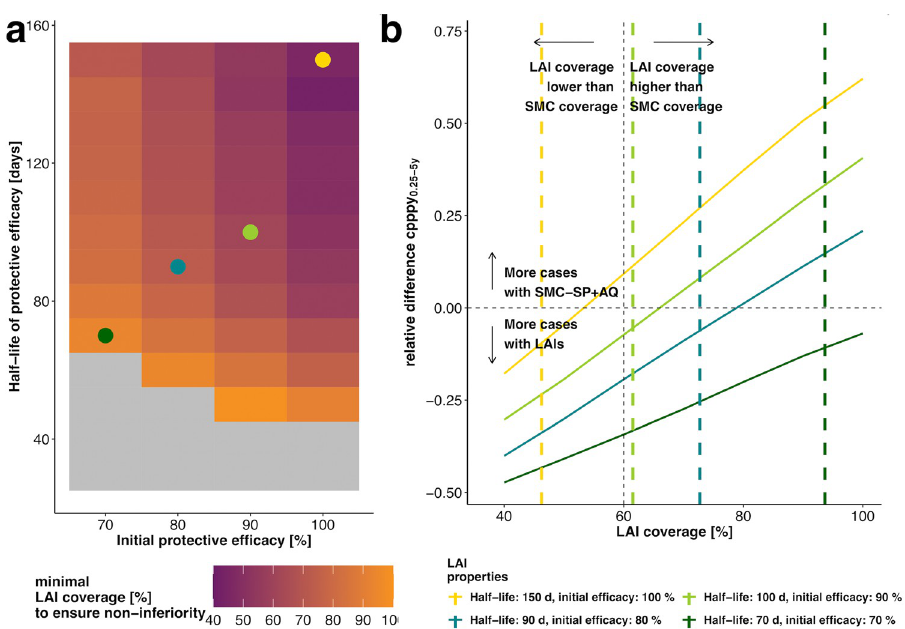
Fig 5. Estimated minimal LAI coverage required during implementation stages to achieve non-inferiority in a given setting and predicted gains in cases averted of subsequent sigmoidal LAI coverage increments. (a) Heatmap of the estimated minimal coverage (colour) of sigmoidal LAIs at which non-inferiority to SMC-SP+AQ (assuming a fixed SMC coverage of 60%) is achieved for different combinations of sigmoidal LAI efficacy and half-life. The results are displayed for intervention scenarios with an underlying disease burden of 1.4 cases per person per year 0.25-5y , long malaria transmission season and low access to treatment (E 14 = 0.1). In the grey area, non-inferiority of LAIs could not be established for any coverage. The light blue frames capture the tool characteristics where non-inferiority could be reached with a LAI coverage under the reference SMC-SP+AQ coverage of 60%. Further results for additional settings and decay shapes are provided in the S1 Text (Fig H and I in S1 Text). The coloured dots represent four illustrative LAI profiles for which the corresponding predicted relative differences in cases per person per year 0.25-5y (Eq 5) are calculated in (b-e) five years after LAI introduction over all LAI coverages as compared with SMC-SP+AQ at 60% coverage (vertical dotted line). The predicted positive increase in relative difference in yearly clinical cases (above the dotted horizontal line) means more clinical cases are averted with LAIs than with SMC-SP+AQ. It thus illustrates the benefit of increasing sigmoidal LAI -coverage above the minimal required coverage to achieve non-inferiority (shown by the grey coloured area). Due to the chosen margin of non-inferiority (here 5%, see Material and Methods), LAIs are non-inferior for a slight negative relative difference in cases per person per year 0.25-5y . In the light-blue area in (b), a LAI coverage lower than the SMC-SP+AQ coverage is sufficient to establish non-inferiority. The corresponding analysis for exponential LAIs can be found in Fig J in S1